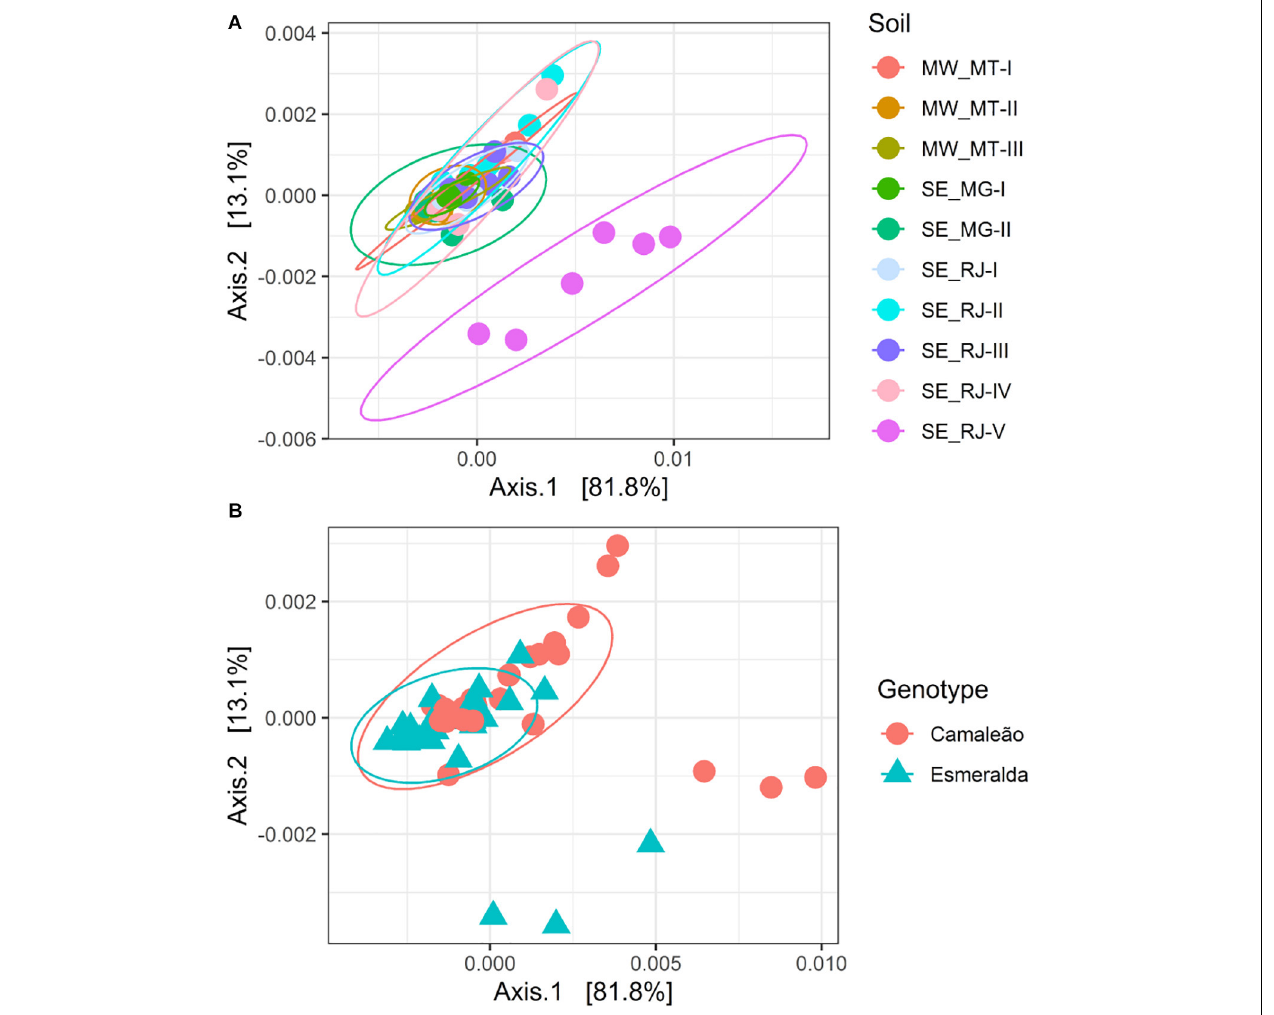
FIGURE 5 | Principal coordinates analysis (PCoA) of Bray-Curtis distances and the Permutational MANOVA (PERMANOVA) according to nodule bacterial communities estimated by 16S rRNA gene sequencing. (A) Samples coded for 10 soil samples ( p = 0.001), and (B) from genotypes Camaleão and Esmeralda of Vigna radiata ( p = 0.002) at the OTU